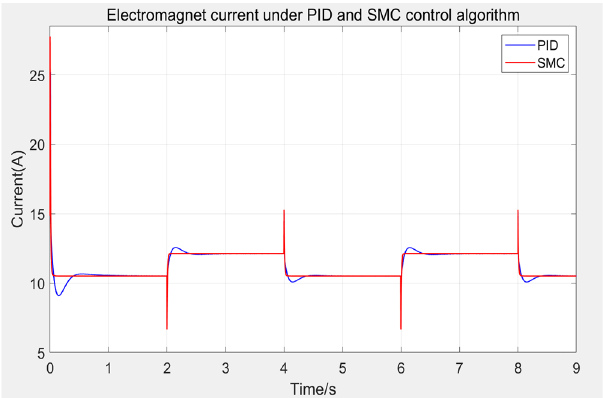
Figure 10. Electromagnet current under PID and SMC control algorithm.